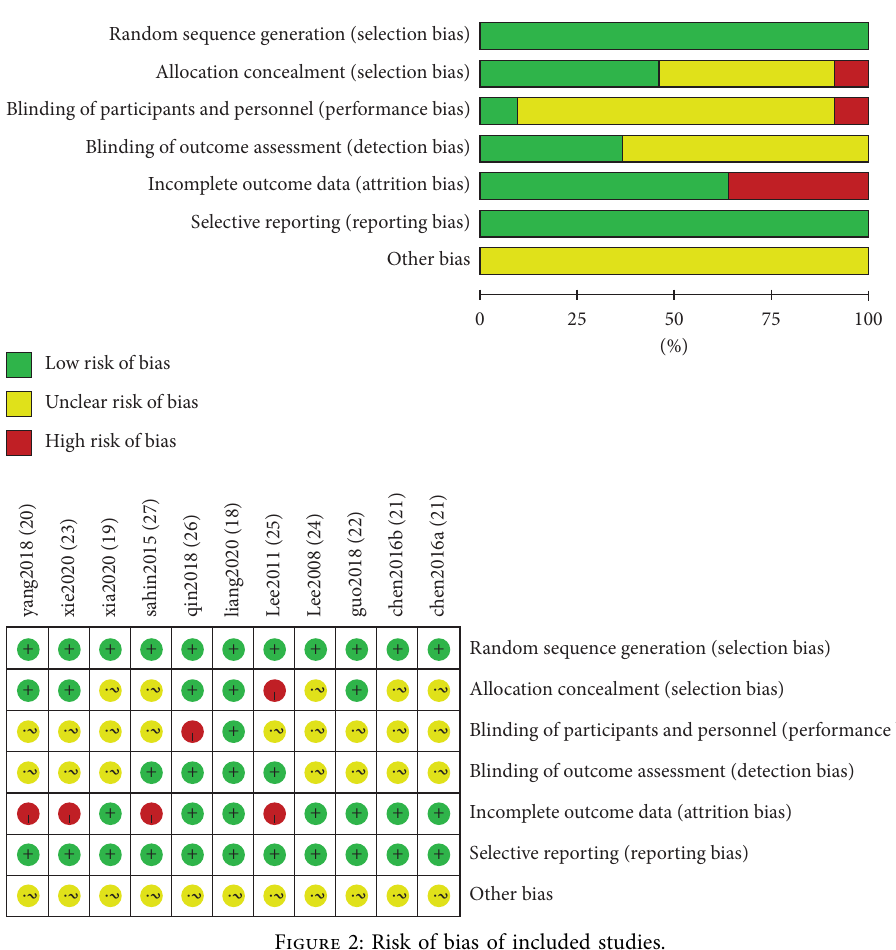
Figure 2: Risk of bias of included studies.